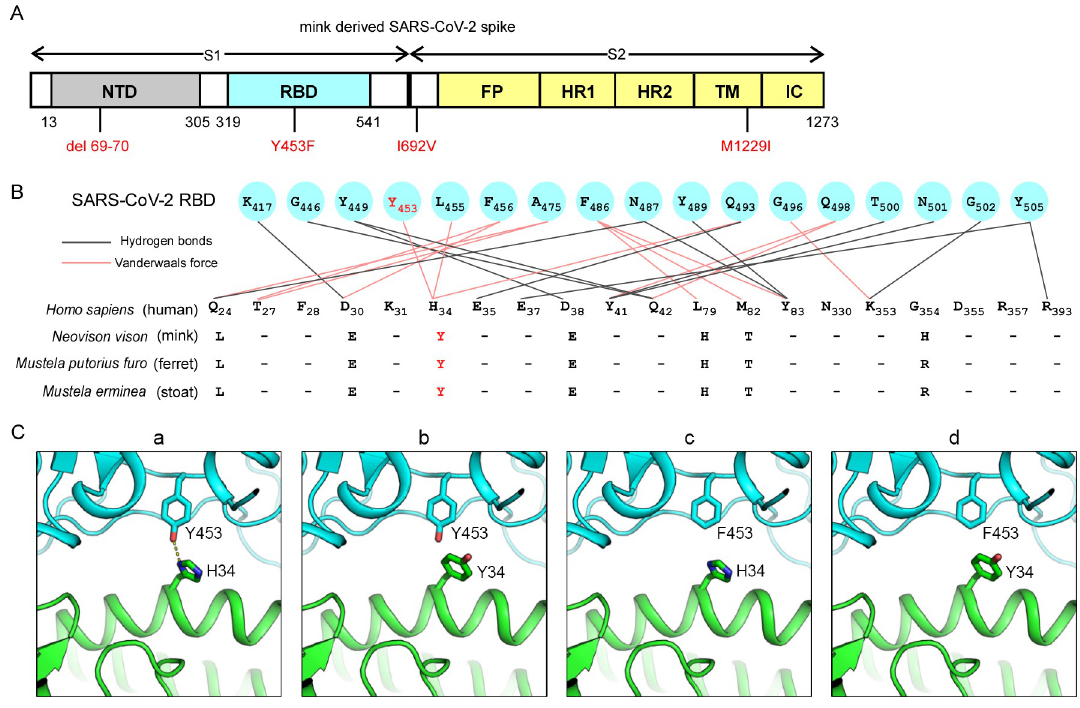
Fig 1. The mutation Y453F in SARS-CoV-2 spike protein is a potential genetic adaptation in minks. (A) Schematic of amino acid changes in the spike protein of miSARS-CoV-2 variant “Cluster 5”. The four genetic changes in the S protein are marked in red. NTD, N-terminal domain; FP, fusion peptide; HR1, heptad repeat 1; HR2, heptad repeat 2; TM, transmembrane region; IC, intracellular domain. (B) Alignment of the residues of human ( Homo sapiens ; NCBI Reference Sequence: NM_001371415.1), mink ( Neovison vison; NCBI Reference Sequence: MW269526.1), ferret ( Mustela putorius furo; NCBI Reference Sequence: NM_001310190.1) and stoat ( Mustela erminea; NCBI Reference Sequence: XM_032331786.1) ACE2 at the interface of ACE2 with the SARS-CoV-2 spike protein. The position of Y453 in the SARS-CoV-2 RBD is colored in red. The Y34 of mink, ferret and stoat ACE2 are highlighted in red. (C) Structural features of the SARS-CoV-2 RBD and ACE2. Contacting residues are shown as sticks at the hACE2-SARS-CoV-2 RBD interfaces (PDB ID: 6M0J). The key residues Y453 of the RBD (a and b) and H34 of human ACE2 (a and c) are labeled. The key residues F453 of the RBD (c and d) and Y34 substitution in human ACE2 (b and d) is labeled. SARS-CoV-2 RBD is shown in cyan, ACE2 in green. The dashed lines indicate hydrogen